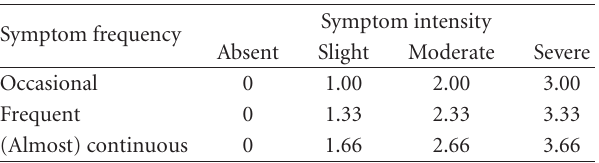
Table 2: Total Symptom Score (TSS): scoring system for neu- ropathic symptoms (pain, burning, paresthesia, and numbness). The score can range from 0 (no symptoms) to maximally 14.64 (all symptoms present, severe,